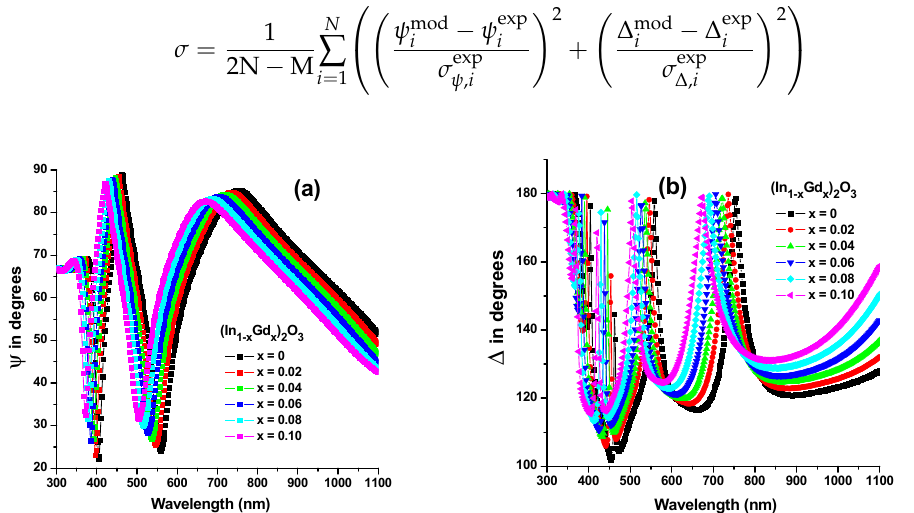
(In 1 − x Gd x ) 2 O 3 layer, and the rough layer. Changes in ψ and ∆ were fit using the mean root square (MRS) function and least square regression as follows: